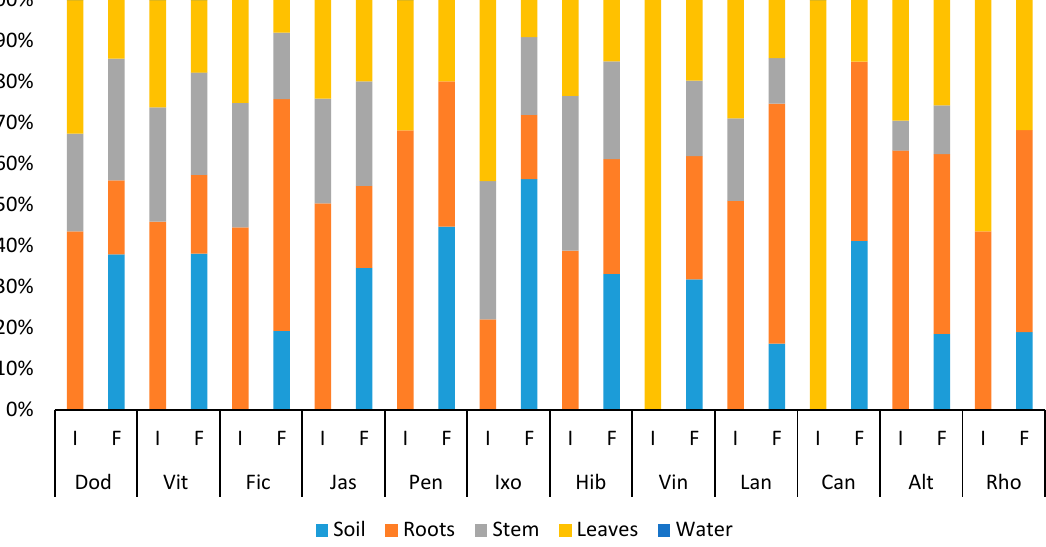
Figure 5. Distribution of Cu in the biofiltration system components at the beginning (I, before irrigation with greywater) and at the end (F, after irrigation with greywater) of the experiment.